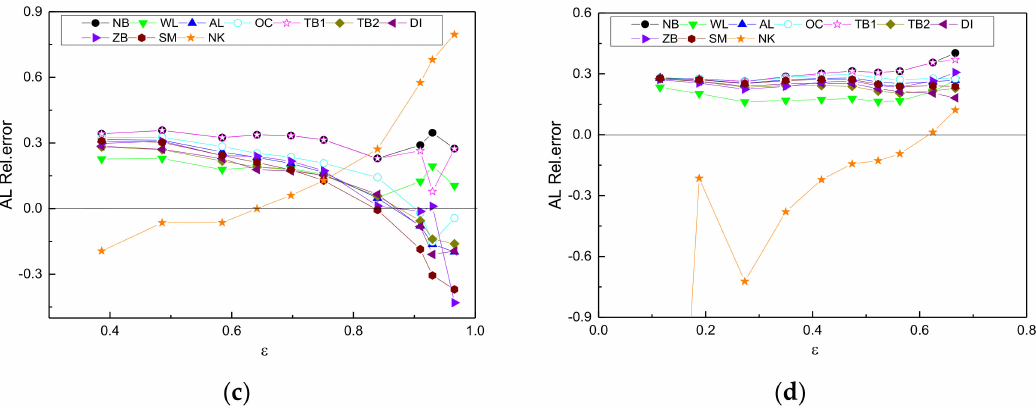
Figure 7. Comparison of relative errors in estimating fatigue life by frequency-domain method (aluminum alloy): ( a ) Single peak spectrum; ( b ) bimodal spectrum; ( c ) multi-peak spectrum; ( d ) band-limited white noise spectrum.